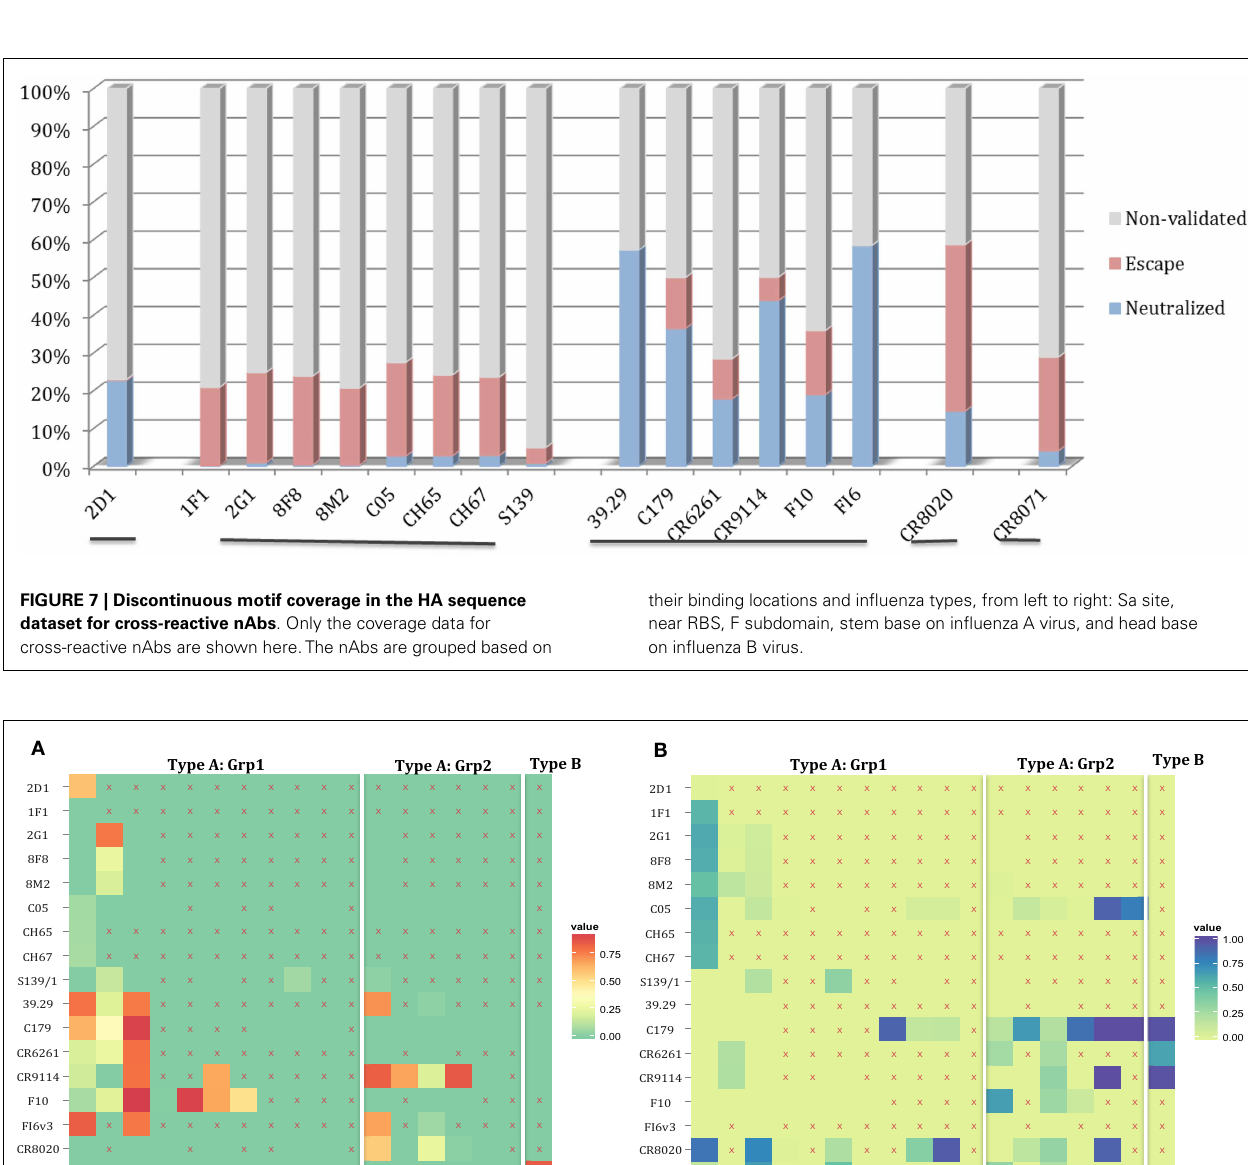
and influenza B virus. Different color schemes were used in order to differentiate neutralizing and escape coverage: from green to red/green to blue indicate rising neutralizing/escape coverage in HA sequence dataset. The boxes with symbol “X” indicate that no experimental validation data were available for this